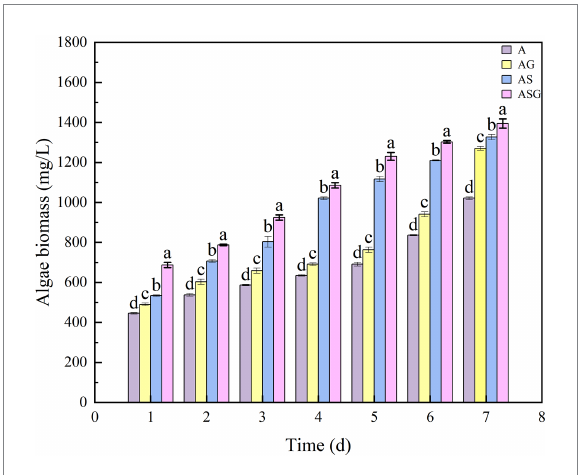
FIGURE 8 Changes of microalgae biomass in different microcosm systems. Different letters indicate p < 0.05, with significant